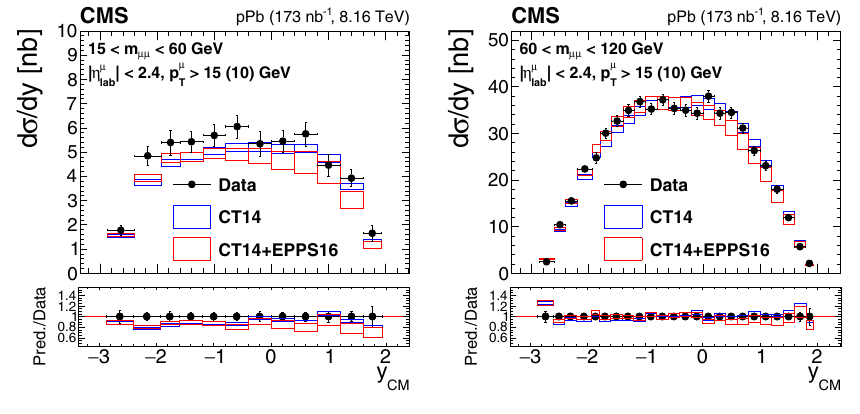
Figure 1. Di ff erential fiducial cross section for the DY process measured in the dimuon channel, as a function of the rapidity in the center-of-mass frame for 15 < m µµ < 60 GeV (left) and 60 < m µµ < 120 GeV (right). The vertical error bars on the data represent the quadratic sum of the statistical and systematic uncertainties. Model predictions from CT14 [12] protn PDF (blue) or CT14 + EPPS16 [3] (red) nPDF sets are shown. The boxes show the 68% confidence level (n)PDF un- certainty on these predictions. The ratios of predictions over data are shown in the lower panels, where the data and (n)PDF uncertainties are shown separately, as error bars around one and as colored boxes,